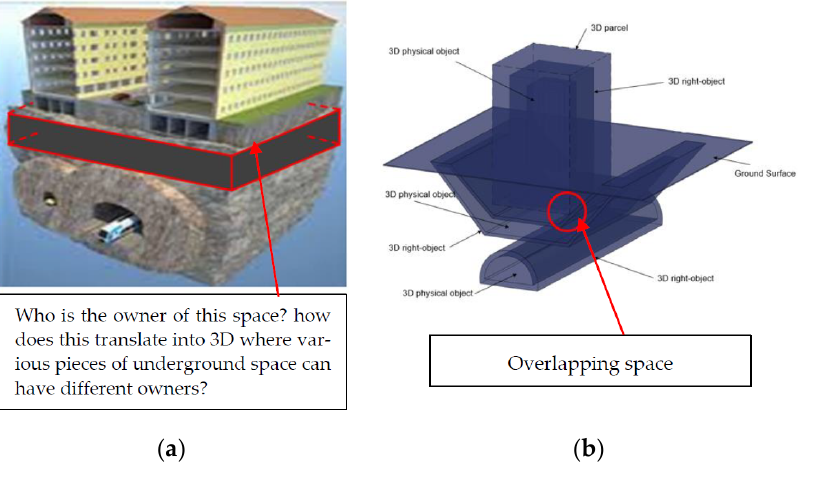
Figure 3. Some examples showing the importance of proper legislation for ( a ) defining the owner- ship of underground areas in 3D (Image source: [28]) and ( b ) revealing the overlapping space of the ownership extent of underground assets and preventing boundary disputes.